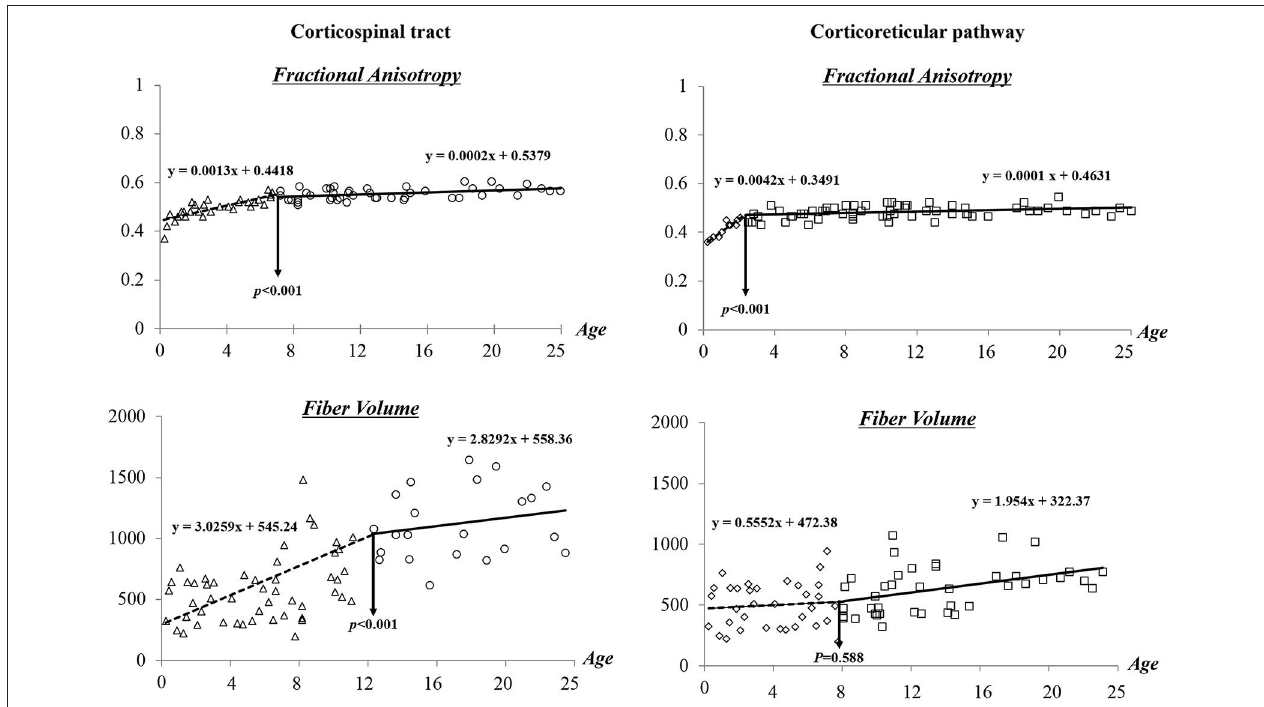
FIGURE 3 | Difference of maturation period in the corticospinal tract and corticoreticular pathway according to